Question: In a single sentence, describe what this figure presents.
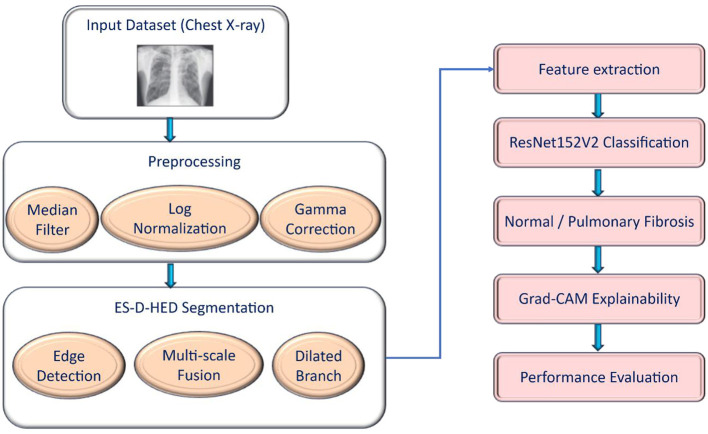
Answer: Comparison of existing lung segmentation and classification approaches.